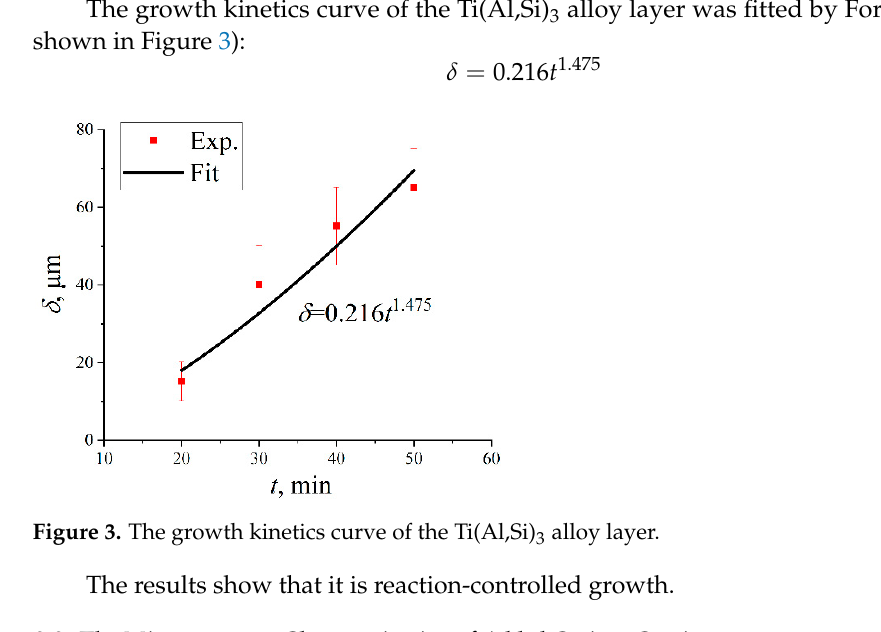
Figure 2. The microstructure of the Ce-added coating at different hot infiltration times, ( a ) 20 min;